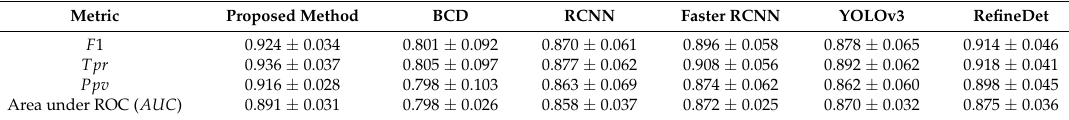
Table 2. Performances (average ± standard deviation) of six compared methods.